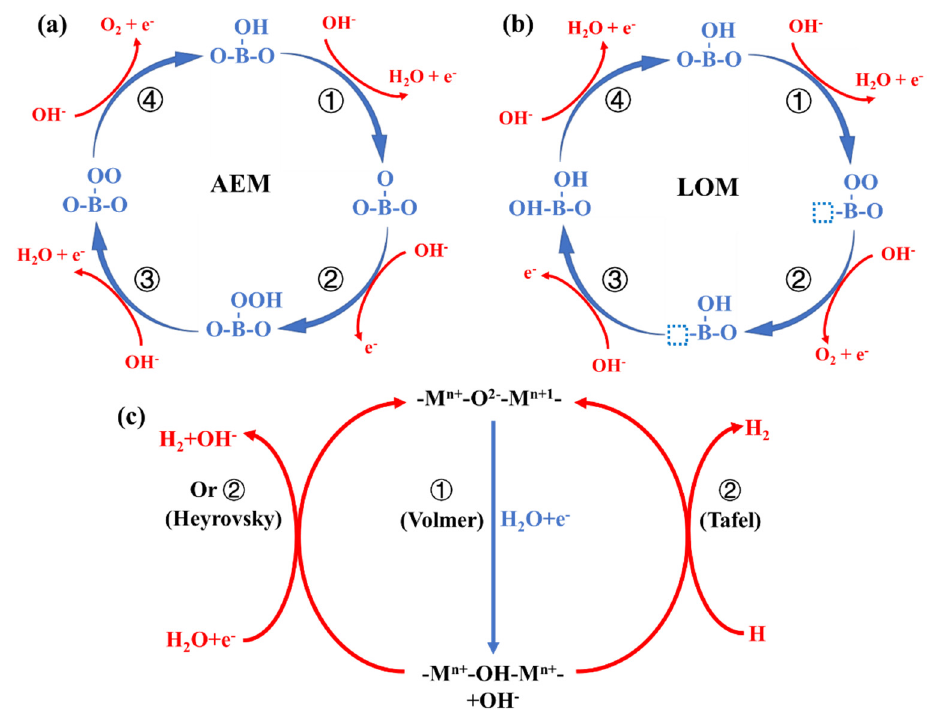
Figure 2. Proposed OER/HER mechanism on perovskite oxide catalysts. ( a ) The adsorbate evolution mechanism (AEM) for the OER on perovskite surfaces in alkaline solutions. ( b ) The lattice-oxygen participation mechanism (LOM) for the OER on perovskite surfaces in alkaline solutions. ( c ) Mechanism for HER on the surface of perovskite oxides in alkaline solutions.